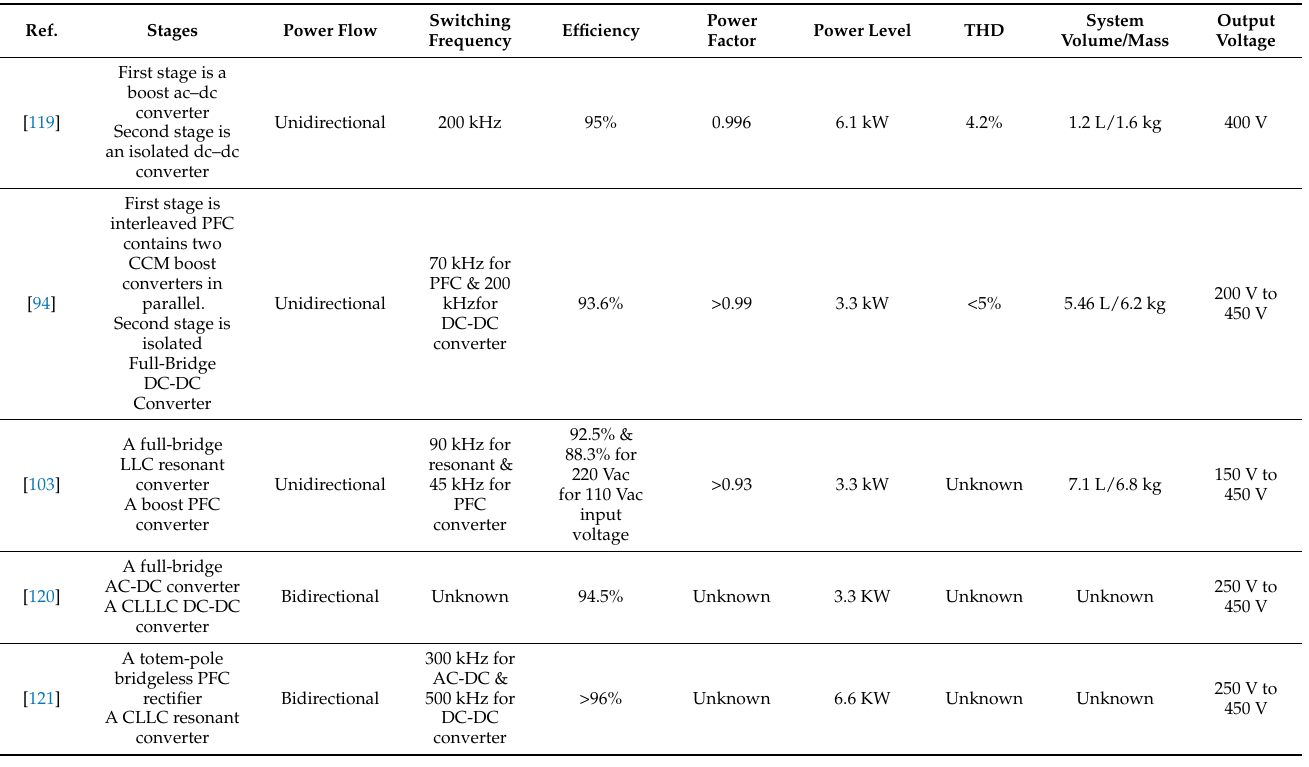
Table 5. Comparison of on-board chargers for electric